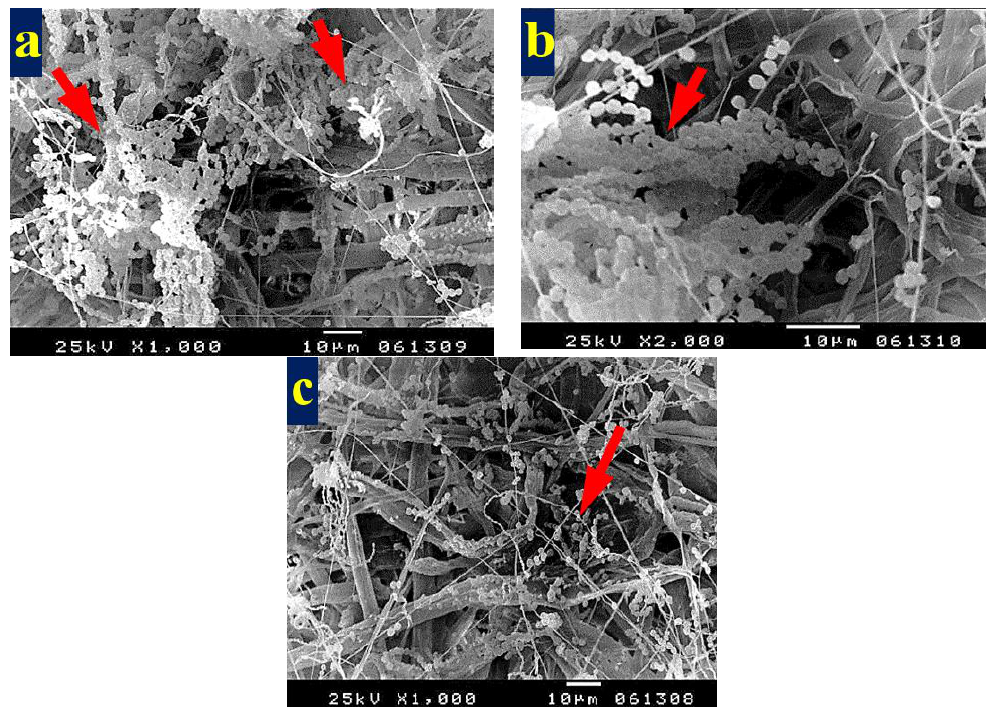
Figure 5. SEM images of E. camaldulensis WB pulp paper manufactured without HeOE additives and inoculated with A. flavus : ( a , b ) without additives and arrows indicate the magnitude of the fungal spores scattered on the surface of the sample fibers, and ( c ) treated with 10% DMSO, where arrow refers to dense growth of fungus mycelia on and between sample fibers.